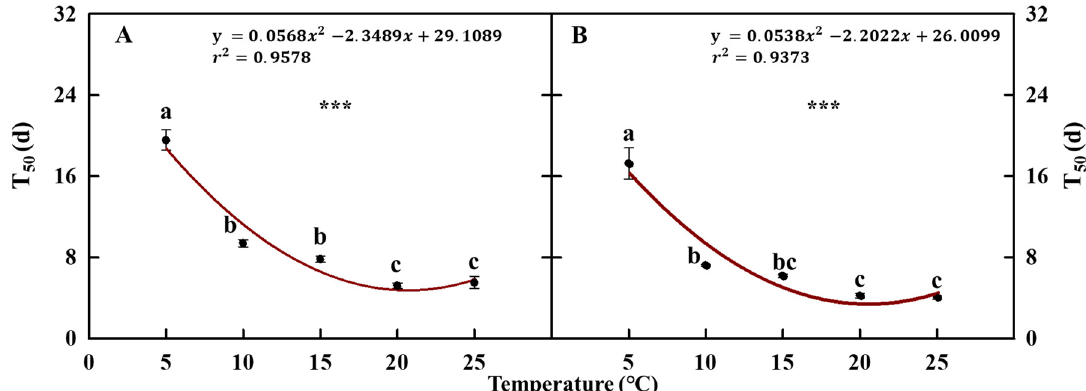
Figure 7. Time taken to achieve 50% (T 50 ) of germination of cold stratification-treated coastal glehnia seeds with pericarps ( A ) and without pericarps ( B ) at five different air temperatures (5, 10, 15, 20, and 25 °C) for 31 days. The vertical bars indicate standard errors. Different letters showed significant differences. *** indicates significance at p < 0.001 ( n = 4).